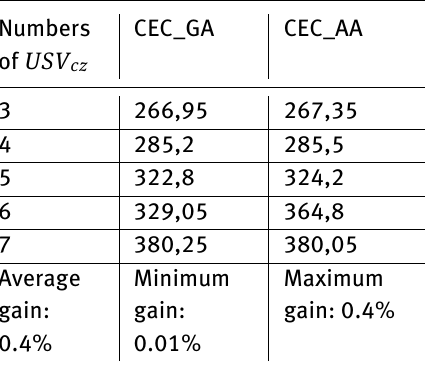
Table 3: Displacement - cleaning energy consumption in a zone with a low degrees of